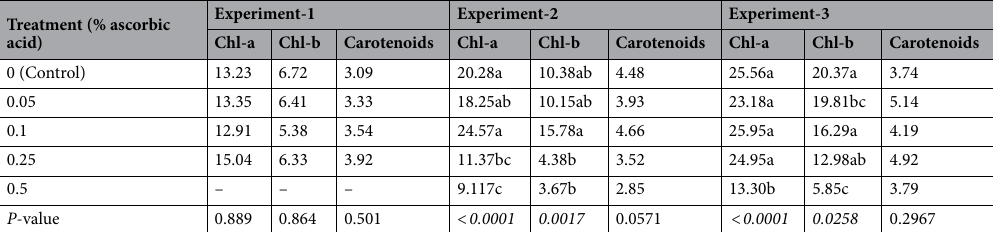
Table 3. Chlorophyll-a, Chlorophyll-b and carotenoids in microgreens treated with different application concentrations of ascorbic acid in 3 experiments. Significant values are in italics. Significant differences ( p ≤ 0.05) between treatments are indicated by different lowercase letters within the column.